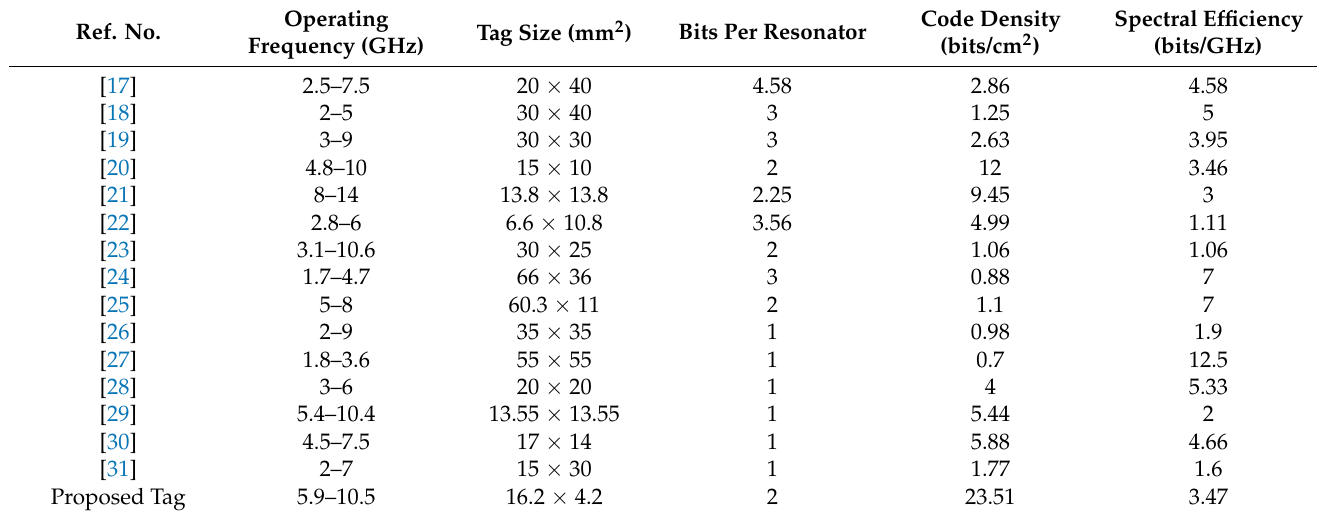
Table 1. Comparison with state-of-the-art CRFID